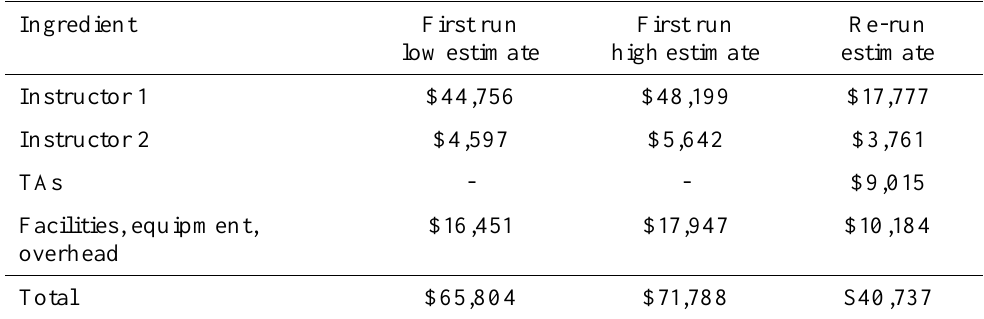
Table 3 Estimated Costs for the First Run of CCK08 and Re-run